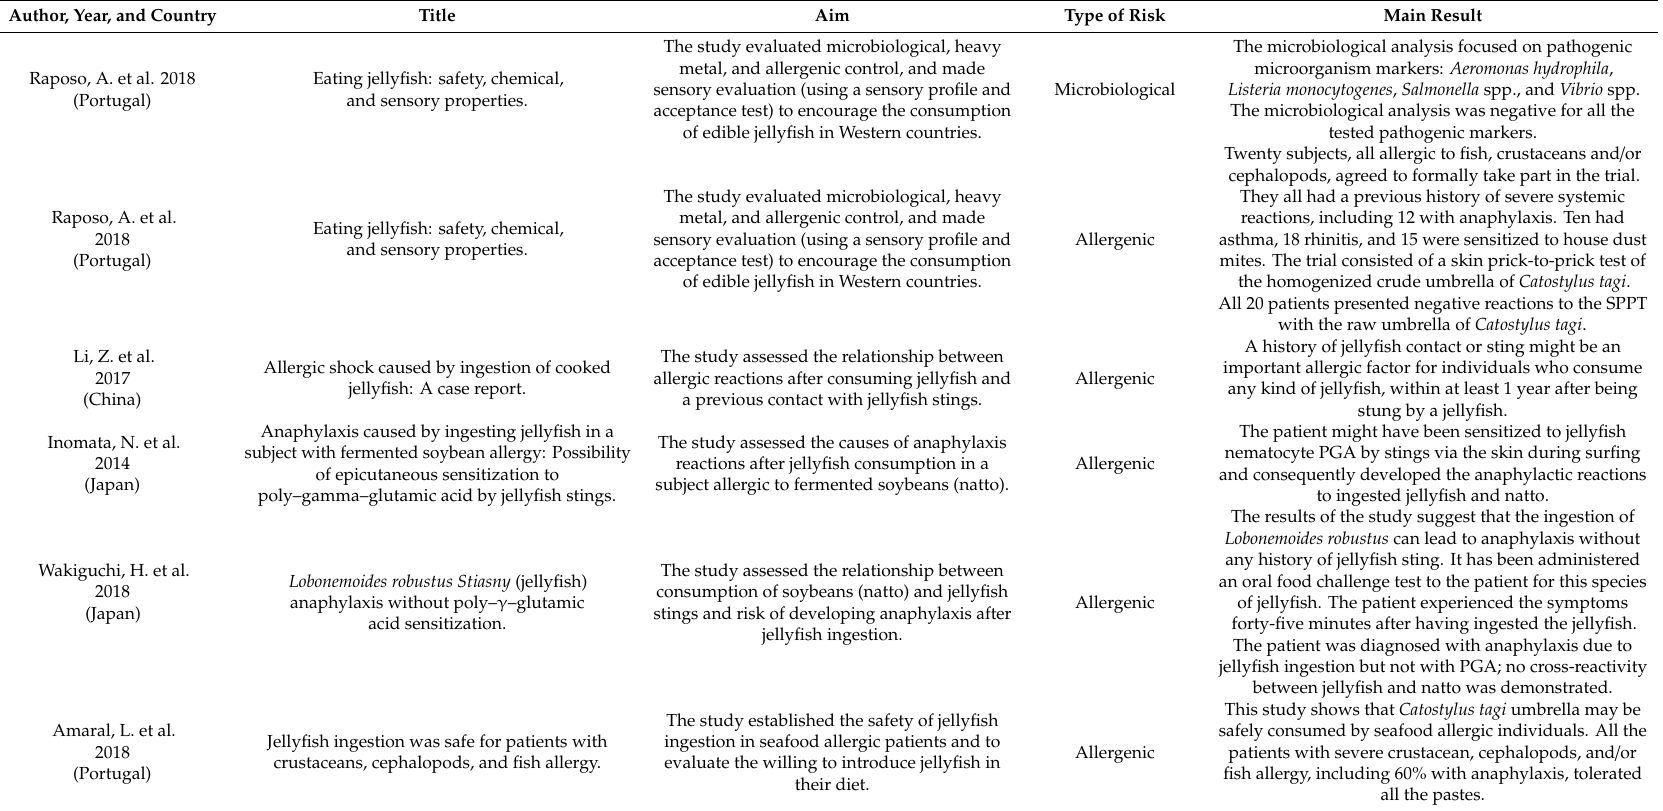
Table 1. Main characteristics of the studies included in the systematic